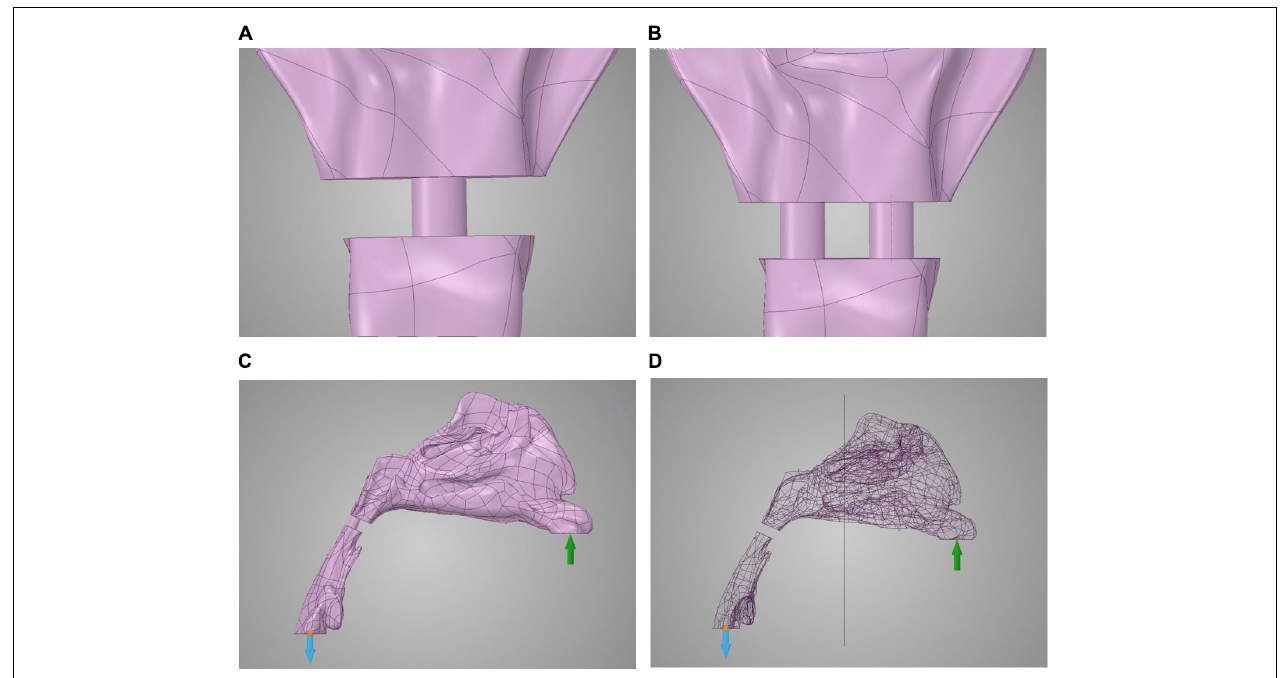
FIGURE 1 | Model reconstruction of normal velopharyngeal closure and velopharyngeal closure after PPF. (A) One cylinder for one port under normal velopharyngeal closure, (B) two cylinders for the two ports under velopharyngeal closure after posterior pharyngeal flap palatoplasty, (C) the boundary set, and (D) the plane to divide the whole airway for calculating the airflow pressure in the nasal cavity. The green arrow represents the input of airflow, and blue arrow represents the output of airflow.